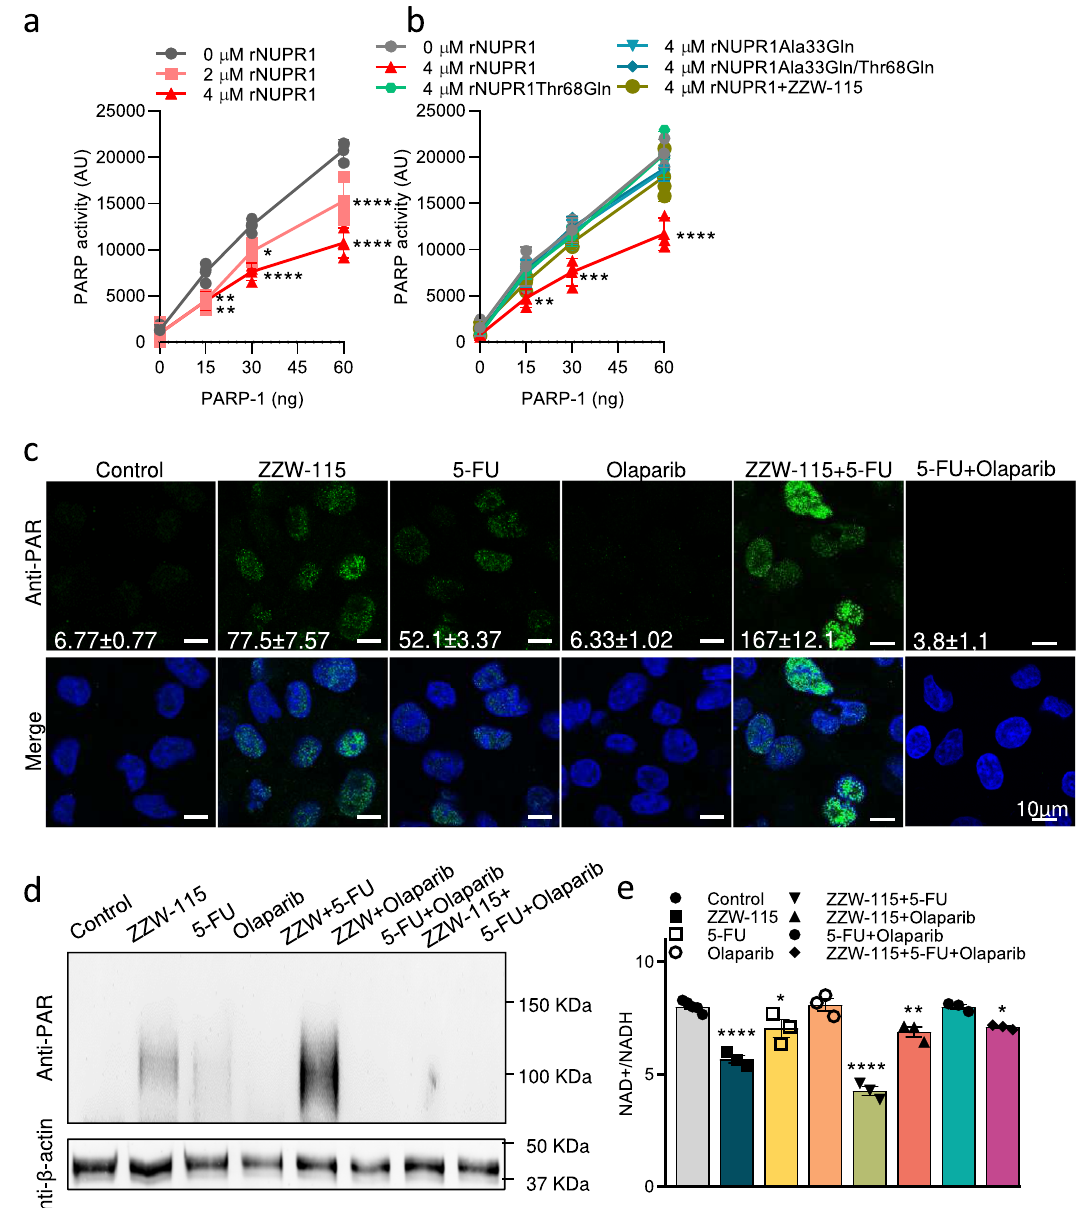
Fig. 2 NUPR1 inhibition increased PARP1 activity in vitro and in cellulo. a PARP1 enzymatic activity was measured in vitro alone or in combination with 2 or 4 µ M of recombinant WT-NUPR1 ( n = 3). b PARP1 enzymatic activity was measured in vitro alone or in combination with 4 µ M of recombinant wild- type-NUPR1, or mutants recombinant NUPR1 proteins (Thr68Gln, Ala33Gln, Thr68Gln/Ala33Gln) and wild-type recombinant NUPR1 in the presence of ZZW-115 ( n = 3). Data represent mean ± SEM. Two-way ANOVA with Sidak correction * P < 0.05; ** P < 0.01; *** P < 0.001; **** P < 0.001. c Immuno fl uorescence was performed in MiaPaCa-2 cells in the presence or absence of ZZW-115 at 1.5 µ M, 5-FU at 10 µ M, olaparib at 25 µ M, ZZW-115 together with 5-FU or 5-FU in combination with olaparib. Mouse anti-PAR and Alexa 488-labeled goat anti-mouse secondary antibodies were used. A representative experiment is shown ( n = 3). ImageJ was used to count the number of green dots. Mean ± SEM of foci/nucleus are included. d Western blot analysis was performed in MiaPaCa-2 cells to evaluated PAR levels after treatments during 24 h (ZZW-115 at 1.5 µ M, 5-FU) at 10 µ M, olaparib at 25 µ M or their combination) ( n = 3). e NAD + /NADH ratio was measured after 24 h treatment at the concentrations previously described ( n = 3). Data represent mean ± SEM. One-way ANOVA, Dunnett correction; * P < 0.05; ** P < 0.01; *** P < 0.001; **** P <